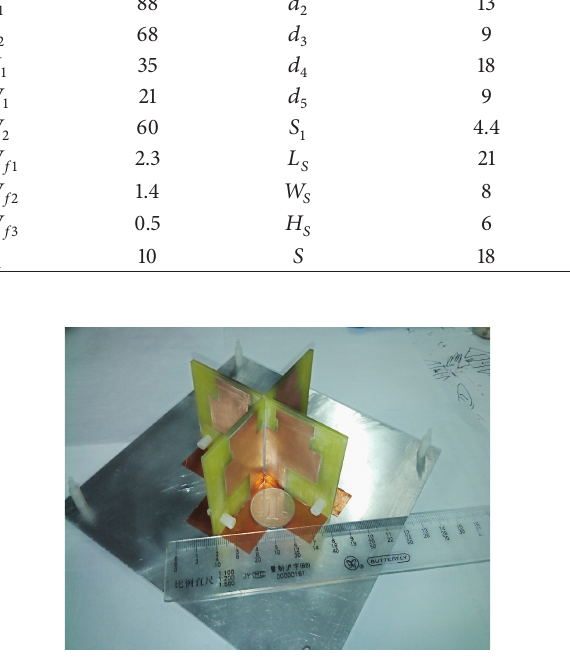
Figure 5: The prototype of the broadband dual-polarized antenna.